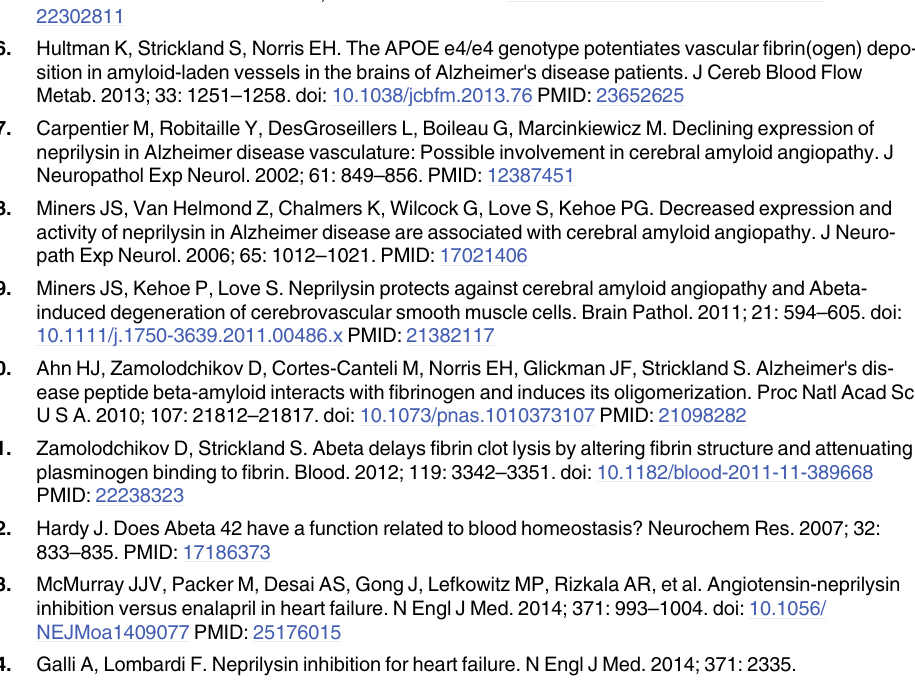
PLOS ONE | DOI:10.1371/journal.pone.0158114 July 20,